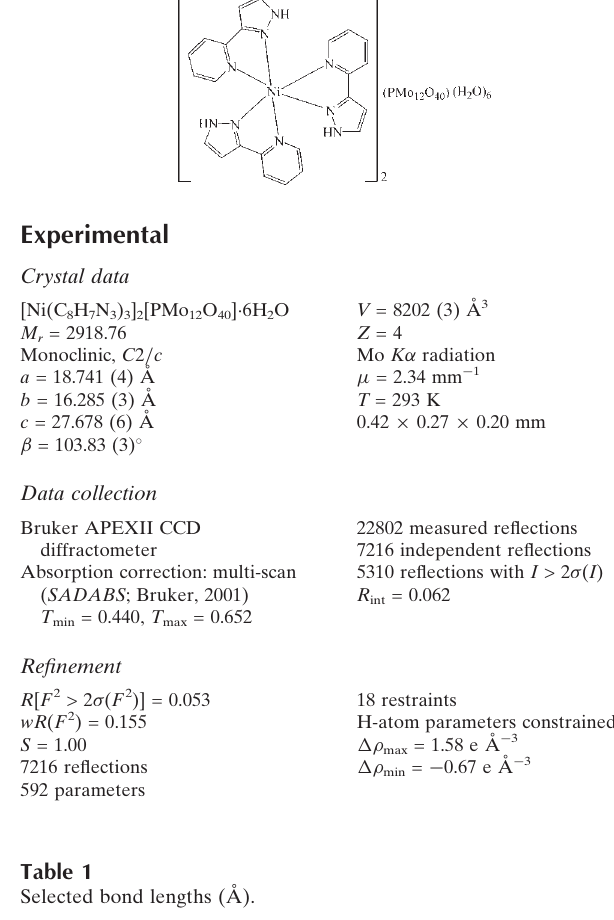
Selected bond lengths (A˚ ).